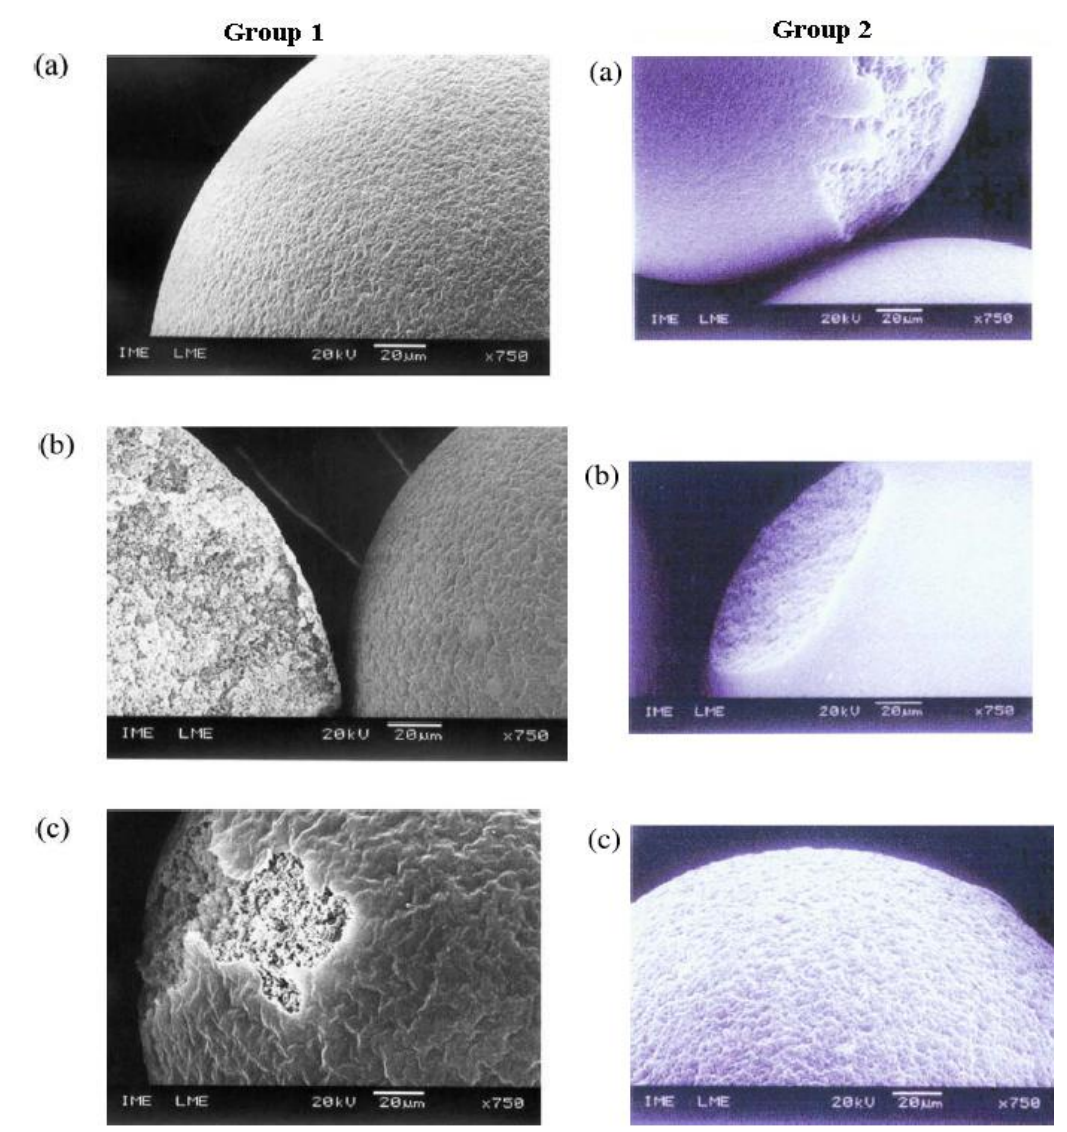
Figure 9. Group 1 : SEM micrographs of the resins prepared with 150 % dilution using n -heptane/toluene as a diluent system at variable 2-vinyl pyridine/styrene/divinylbenzene ratios; ( a ) 30/4030; ( b ) 40/30/30 and ( c ) 50/20/30. Group 2 : SEM micrographs of the resins synthesized with 100% dilution using n -heptane/ethyl acetate as a diluent system at 2-vinyl pyridine/styrene/divinylbenzene ratios; ( a ) 30/4030; ( b ) 40/30/30 and ( c ) 50/20/30. (Reprinted from [48], Copyright 2004, with permission from